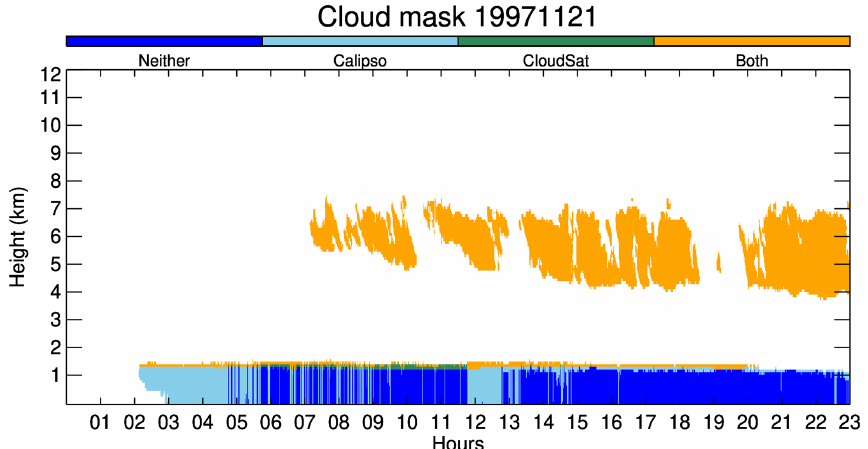
Figure 3. Cloud mask vertical profile based on simulated CloudSat reflectivity and cloud optical thickness for CALIPSO on 21 Novem- ber 1997 collected during the SHEBA experiment.